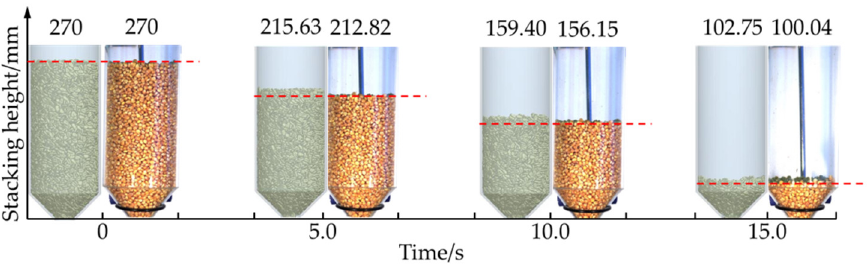
Figure 6. Comparative results of the corn grain flow simulation and high-speed camera